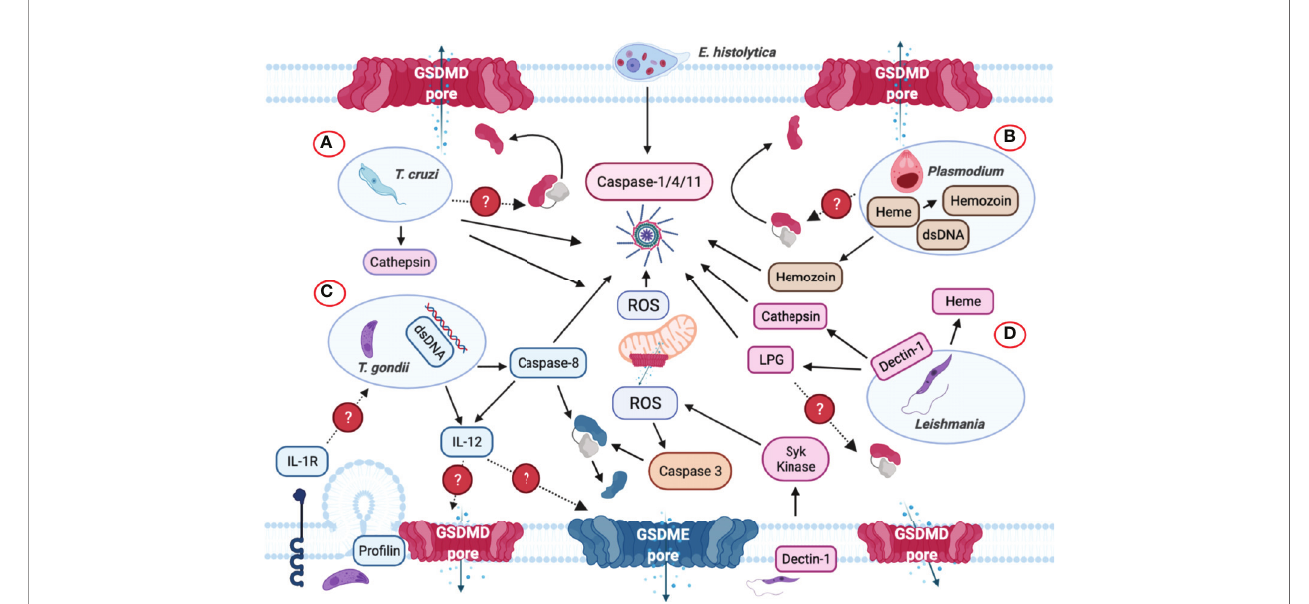
FIGURE 8 | In fl ammasome and GSDMs regulation by intracellular protozoan parasites. (A) Trypanosoma cruzi triggers NLRP3 in fl ammasome activation when the parasite lyses the parasitophorous vacuole to gain access to the cell cytoplasm. Cathepsin and reactive oxygen species (ROS) are involved in NLRP3 in fl ammasome activation. (B) Plasmodium -derived molecules such as hemozoin and dsDNA are released to the host cell cytosol upon lysosomal rupture and cathepsin release that trigger activation of the NLRP3 in fl ammasome. dsDNA can trigger NLRP3 in fl ammasome activation via the generation of ROS and membrane disruption. It is unclear